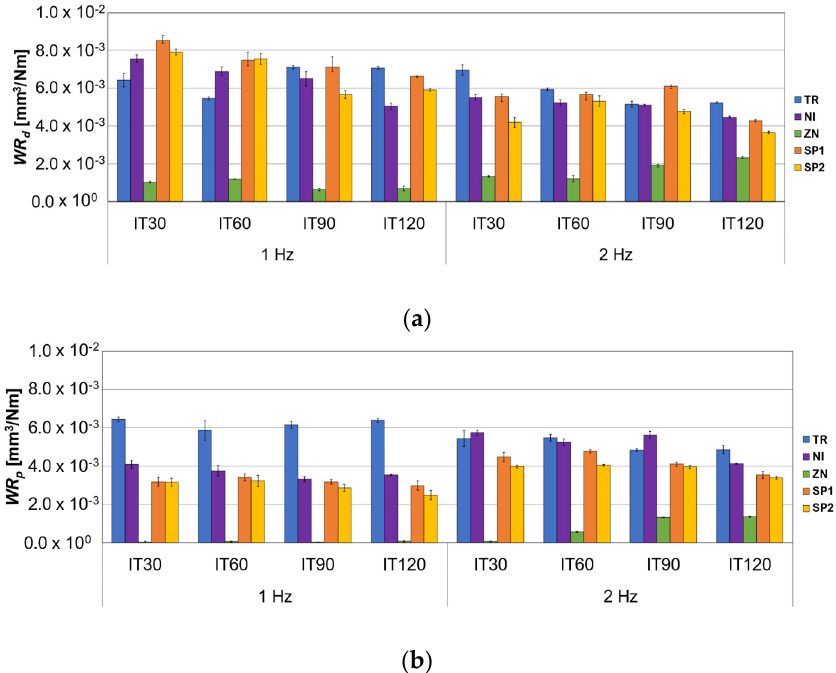
Figure 11. Influence of the duration of the tribological test on the specific wear rate for ( a ) disks and ( b ) pins. Error bars indicate the uncertainty of the measurements as standard deviation.